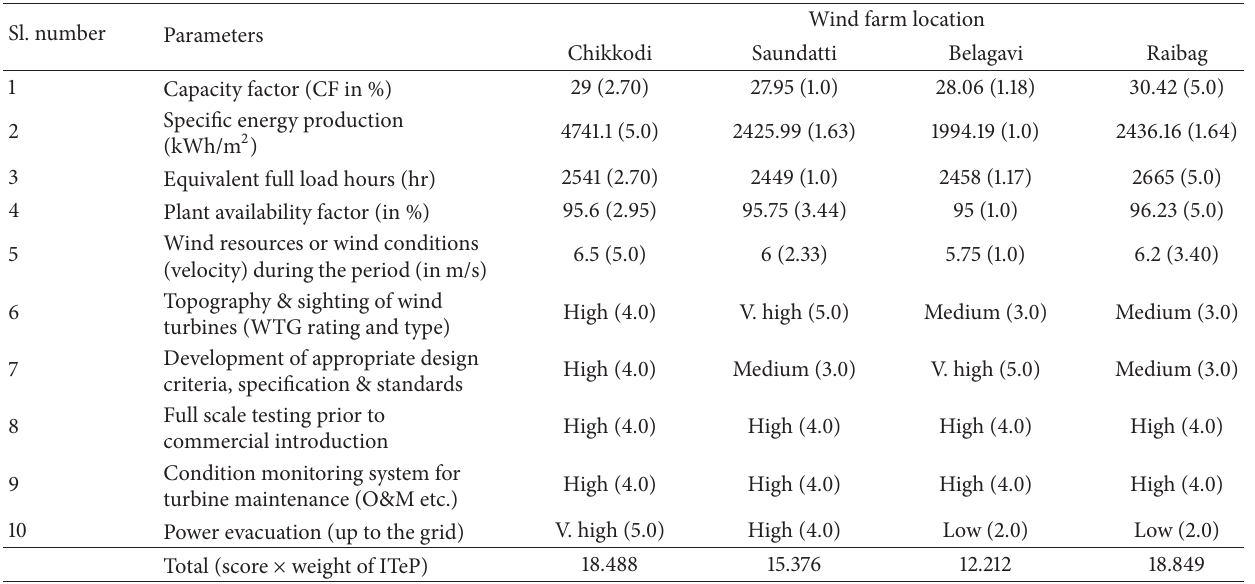
Table 2: Comparison of the wind farms based on technical performance indicators (ITeP). Sl. number